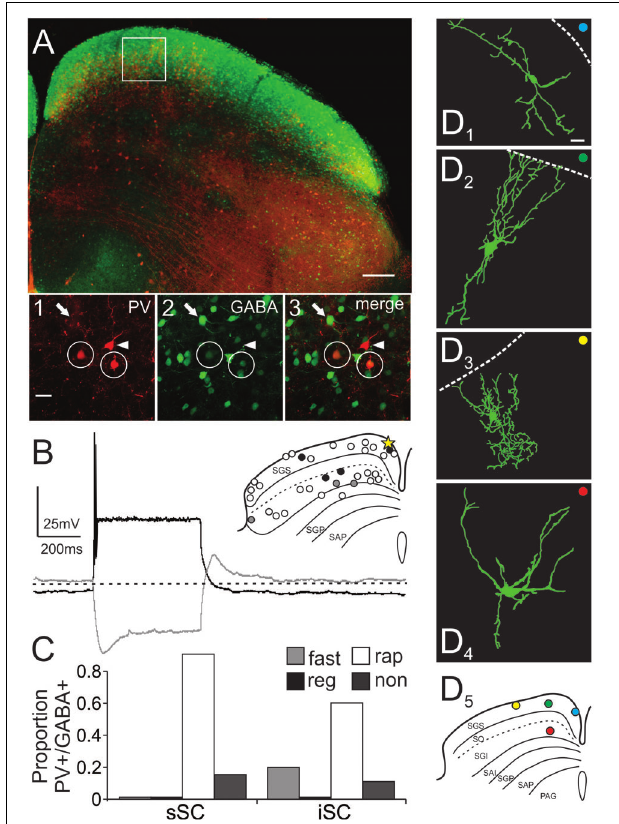
FIGURE 5 | PV + /GABA + neurons in the SC are predominantly stellate and rapidly inactivating neurons. (A) Low magnification confocal image of a slice from an Ai9;PV-Cre;GAD67 mouse depicting PV + (tdTomato) and GABA + neurons (eGFP) in the SC. Scale bar: 200 µ m. White box shows the area selected for further visual analysis. (A 1 − 3 ) High magnification confocal images showing PV + (white arrowhead), GABA + (white arrow), and double-labeled PV + /GABA + (white circle) neurons imaged from the location shown in the white box in (A) . Scale bar: 20 µ m. (B) Representative traces of a single PV + /GABA + neuron recorded from sSC (inset, yellow star). The white (rap; rapidly inactivating), black (non; non-spiking), and gray (fast; fast spiking) circles in the inset depict the location and corresponding firing pattern for each of the recorded neurons. (C) Proportion of PV + /GABA + neurons according to their firing patterns from sSC and iSC. (D) Drawings of PV + /GABA + neurons; (D 1 ) horizontal, (D 2 ) narrow field vertical, (D 3 ) stellate in sSC, and (D 4 ) stellate in iSC. Scale bar: 20 µ m. (D 5 ) Shows the locations of the neurons shown in (D 1 − 4 ) . Note that all these neurons are portrayed in the inset in (B) and were rapidly inactivating (white